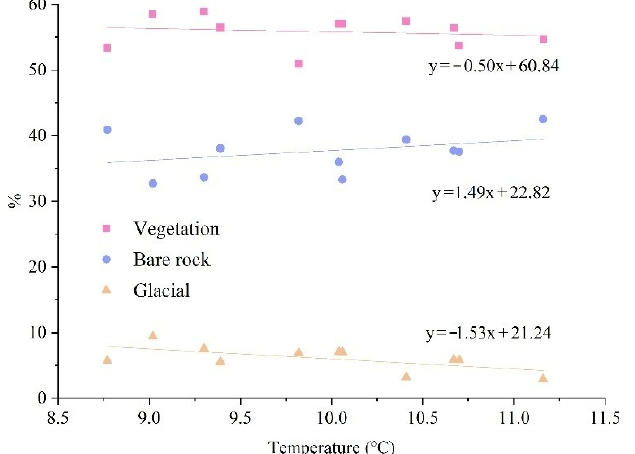
Figure 6. The proportional relationship between landscape categories and mean annual temperature in Sobchaye. in